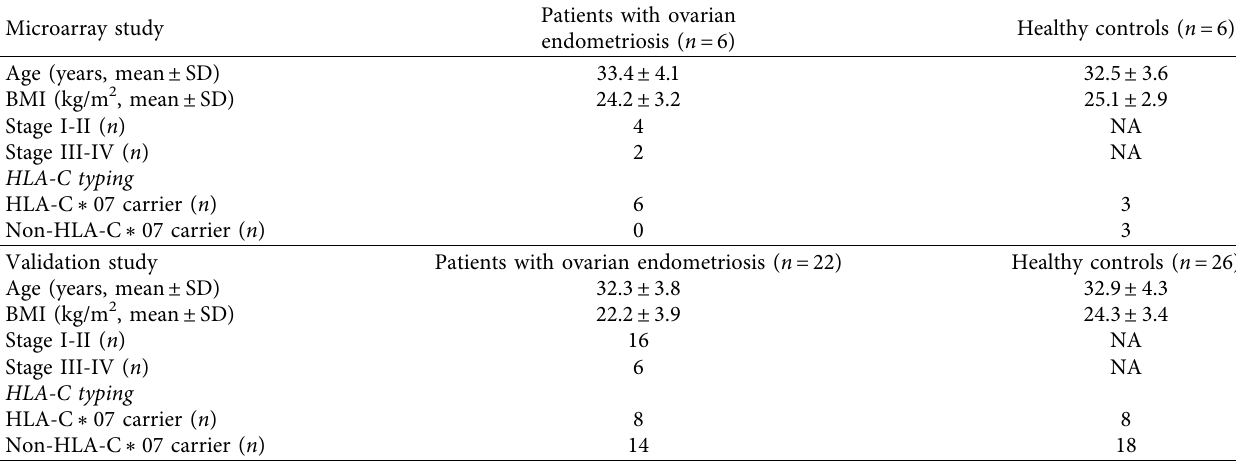
Table 1: General characteristics and HLA-C typing of the study